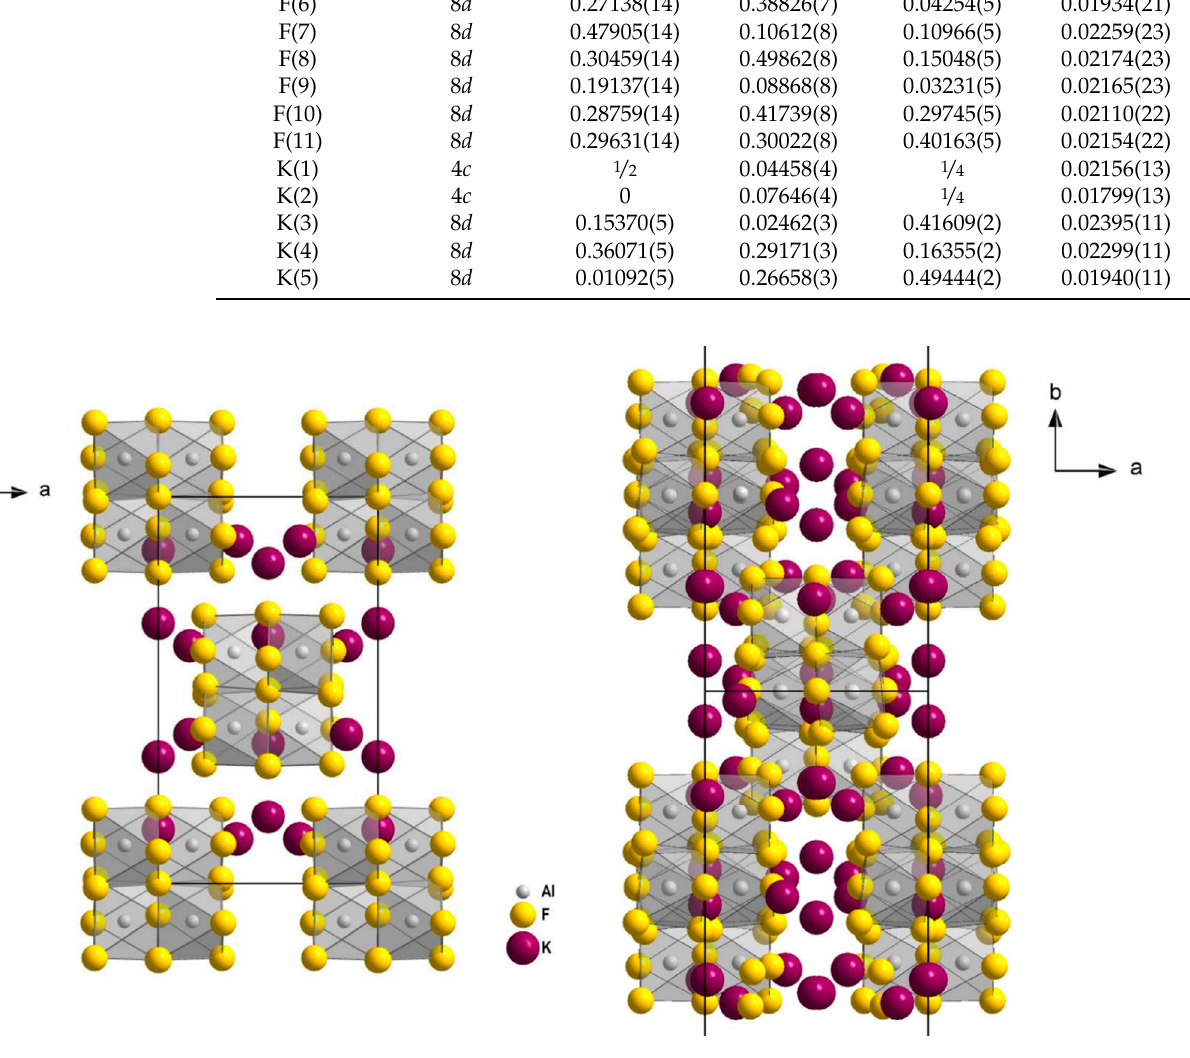
Figure 2. Section of the crystal structures of K 2 AlF 5 -2 ( left ) and K 2 AlF 5 -3 ( right ), shown along [001] emphasizing the motif of hexagonal rod packings by the infinite fluoroaluminate chains. The crystallographic unit cells are indicated by black lines. Table 4. Selected interatomic distances (in pm) in K 2 AlF 5